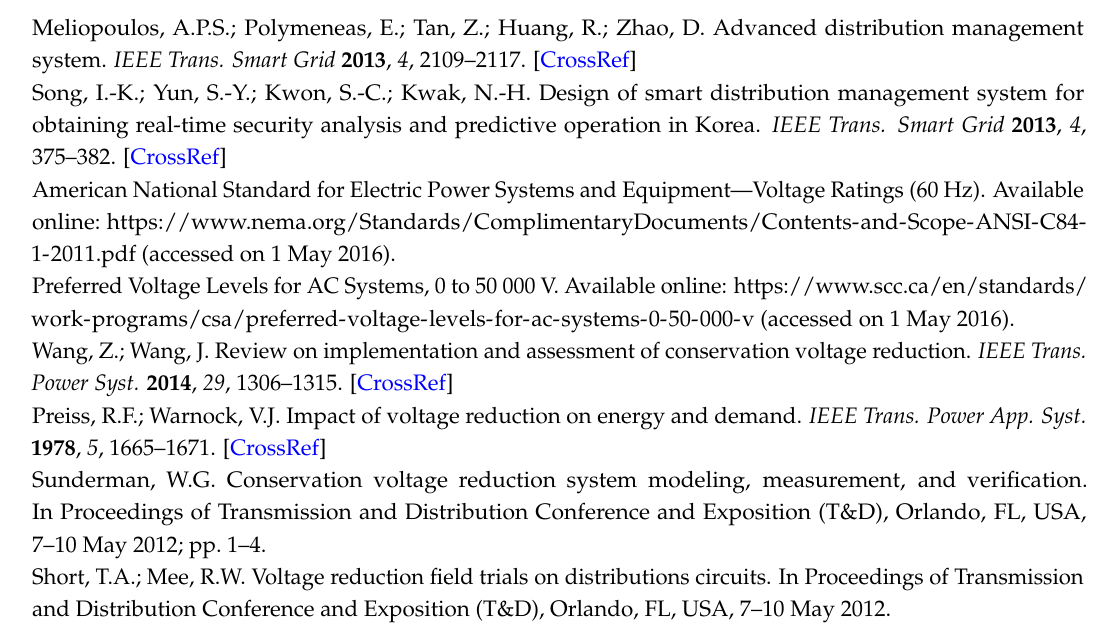
Figure 14. Average reduction of the active power drawn from substation: five ‐ DG system.